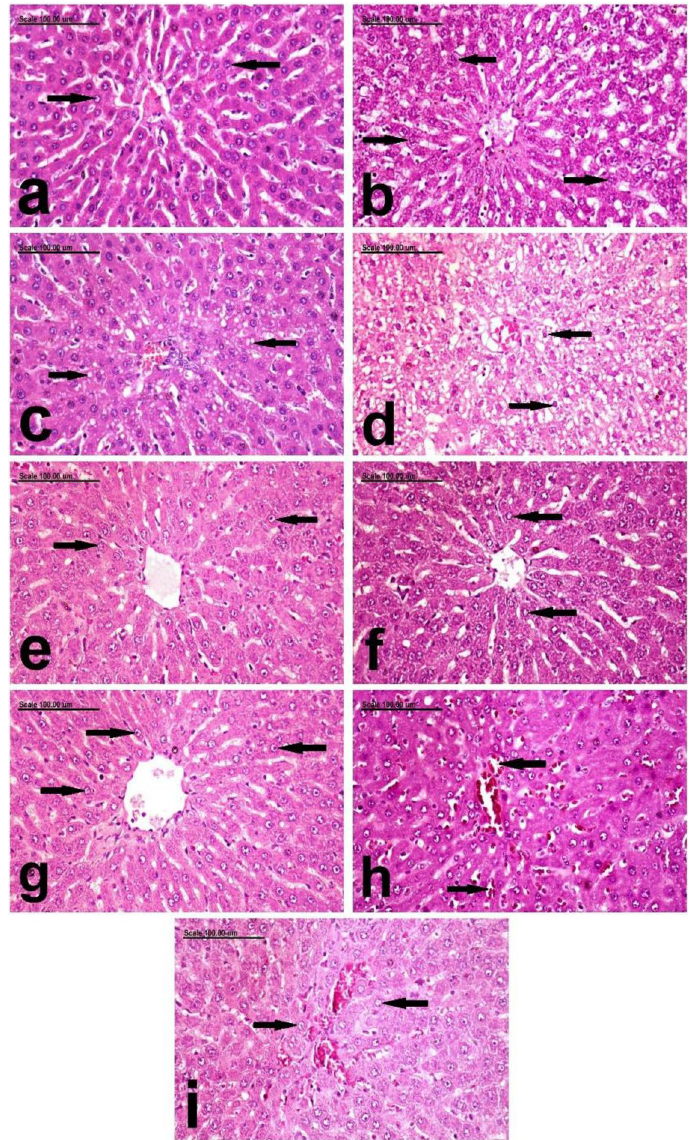
Figure 6. Photomicrograph showing the pathological alterations of the hepatic tissue. photomicrograph from the liver of, ( a ) negative control rats showing normal hepatic parenchyma with normal hepatocytes (arrows), ( b ) C+ ve showing mild granular degeneration of hepatocytes (arrows), ( c ) Prednisolone treated group showing mild focal vacuolar degeneration of hepatocytes (arrows), ( d ) the low dose leave group showing swelling and vacuolation of hepatocellular cytoplasm (arrows), ( e ) the high dose leave group showing normal hepatocytes (arrows), ( f ) low stem-treated groups showing normal histological structures (arrows), ( g ) high dose stem- treated groups showing normal hepatocytes (arrows), ( h ) low dose fruit peels treated group showing mild focal congestion of some hepatic sinusoids (arrows), and ( i ) high dose fruit peels treated groups showing normal heptic parenchyma (arrows) (Stain: H&E; Scale bar = 100